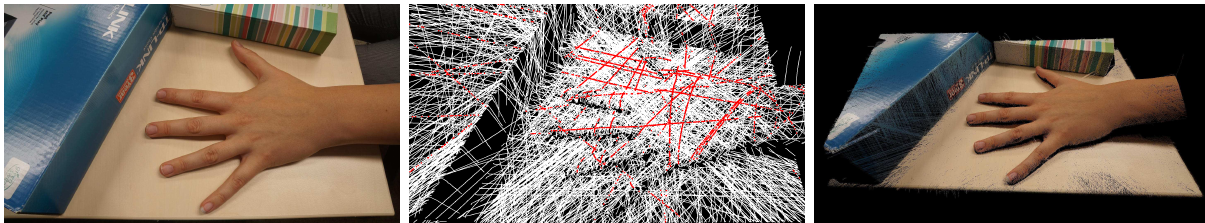
Figure 3: Visualization of the scene, extracted laser curves, and 3D point cloud. Left: Image of the scene from the perspective of the fixed camera used for scanning, Middle: Visualization of a subset of the extracted laser curves in white and intersection points in red, Right: Colored 3D point